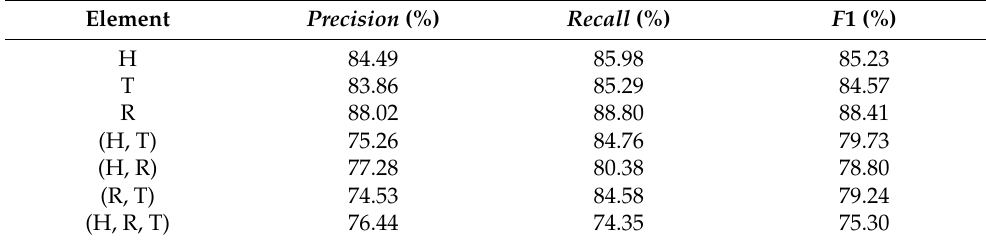
Table 5. Results for relational triplet